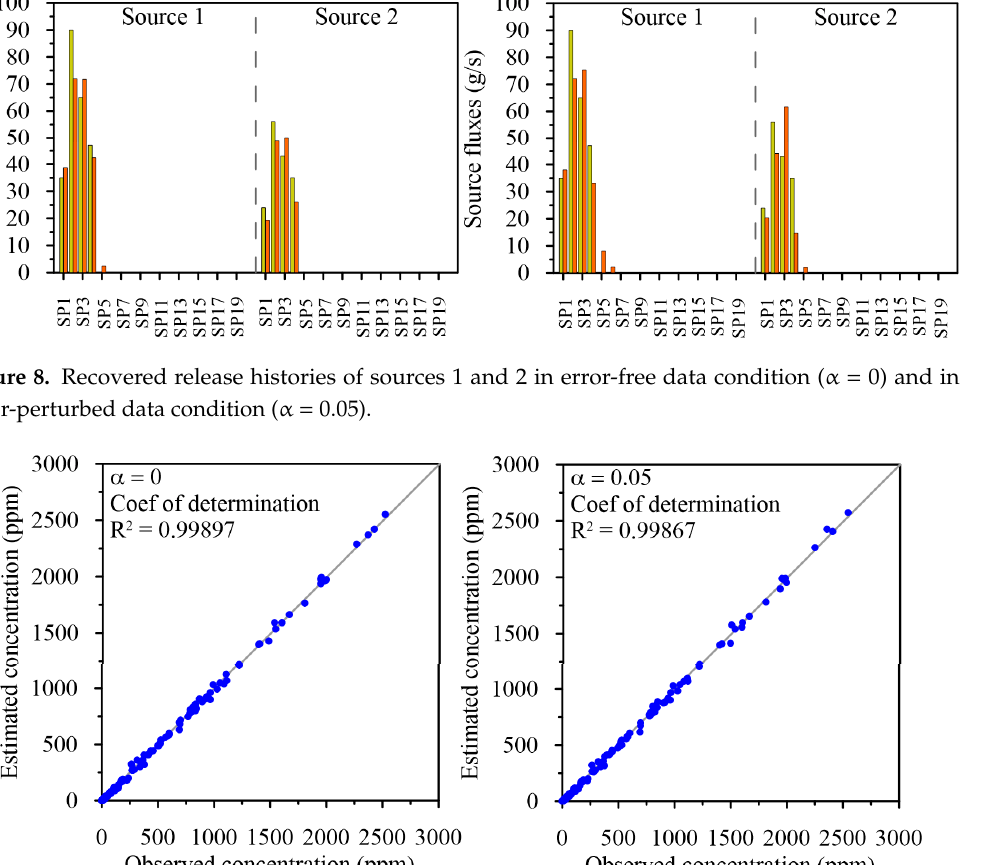
Figure9. Estimatedvs. observedconcentrationinerror-freedatacondition( α = 0)andinerror-perturbed data condition ( α =